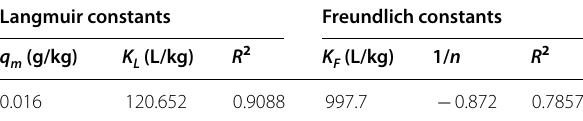
Table 6 Langmuir and Freundlich isotherm constants for the adsorption of [Cr] T ° 21 =